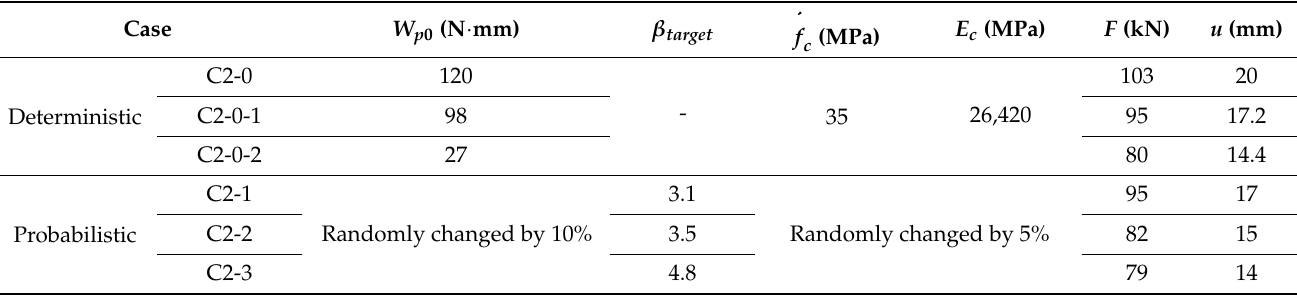
Table 2. Results obtained from C2